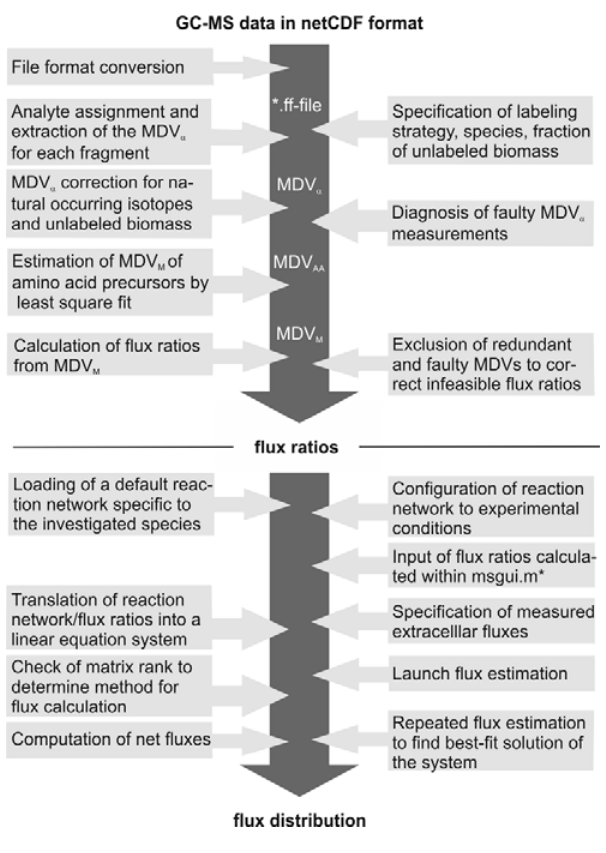
Figure 1. Workflow of 13 C MFA of FiatFlux [5]. The automatic tasks are listed on the left, the manual user interactions on the right